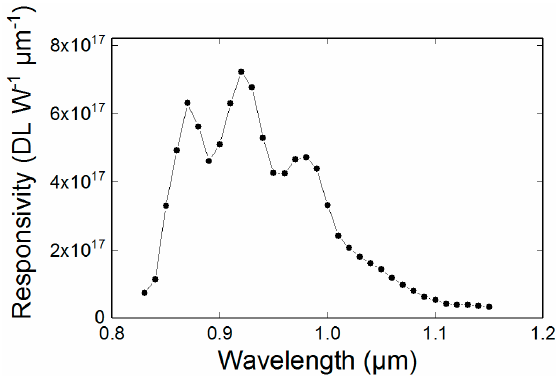
Figure 2. Spectral responsivity of the modified PiCam combined with an 850 nm long pass filter. The oscillatory behaviour is consistent with being caused by etalons in the Bayer removal process. This spectral shape affects the form of the calibration curve as a function of temperature.